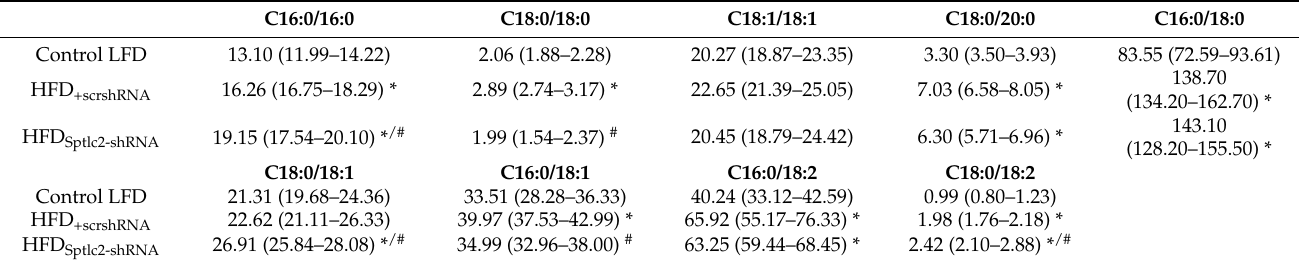
Table 4. The Impact of Sptlc2 Silencing on the Content of DAG in the Mouse Gastrocnemius